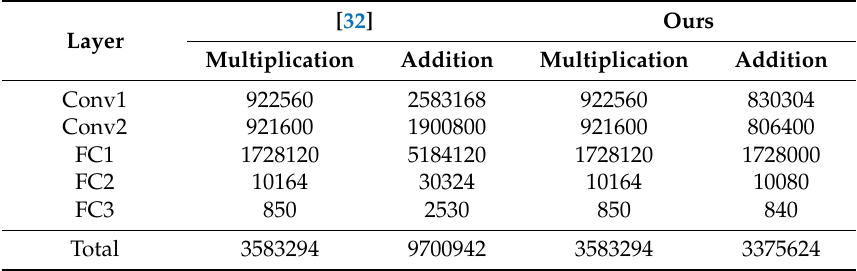
Table 8. Number of multiplications and additions in the proposed scheme and the scheme in [32]. [32] Ours Layer Multiplication Addition Multiplication